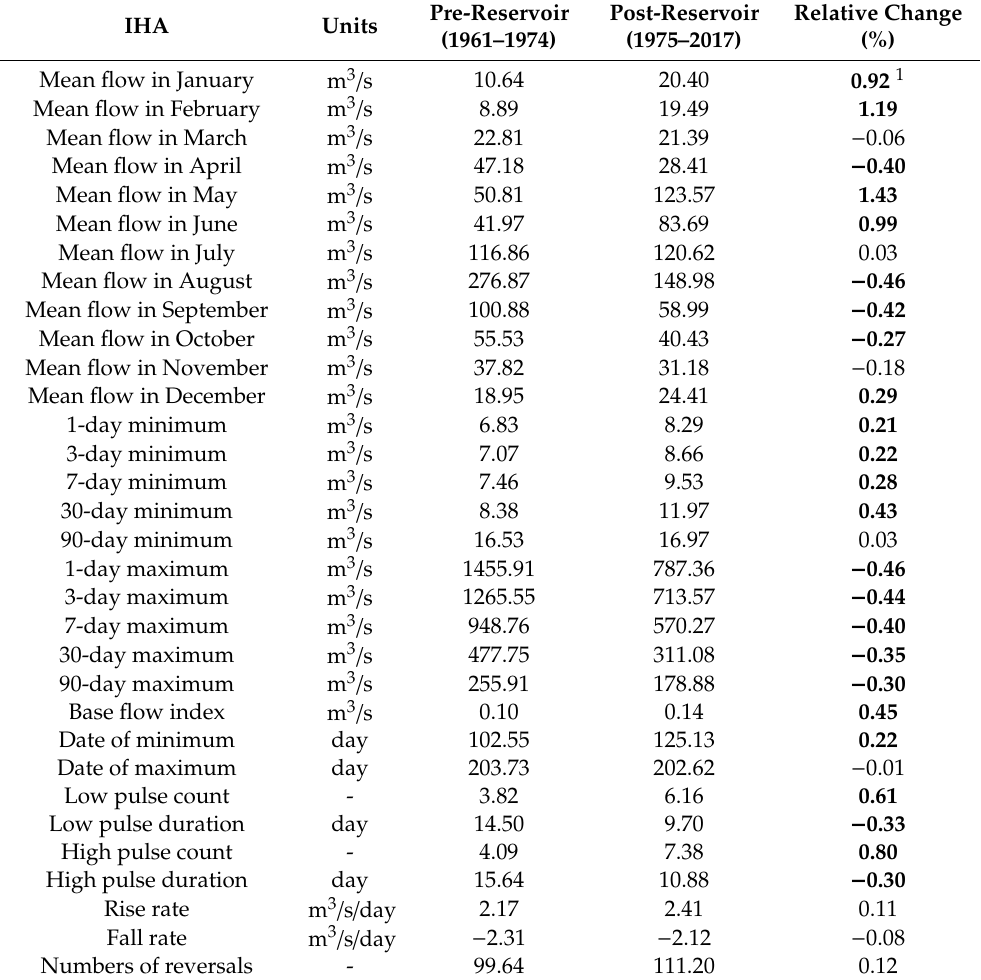
Table 4. IHAs and their relative changes before and after the construction of the